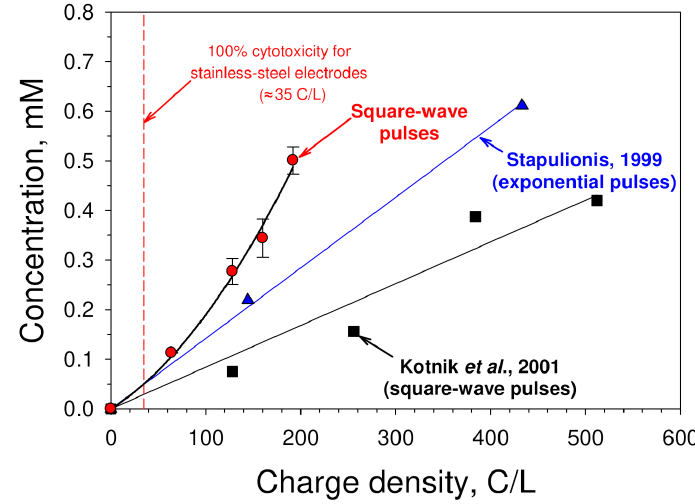
Figure 5. Release of iron ions from stainless steel electrodes. The total concentration of iron ions (Fe 3+ and Fe 2+ ) released from the stainless steel anode as a function of the charge that has flown through the sample per unit volume of the medium. Single square-wave electric pulses with a duration of 2 ms were used (red circles). The highest amplitude of the pulses was 240 V, which corresponded to the electric field strength of 1.2 kV/cm. The solution was 154 mM NaCl. For comparison, some of the results reported by other researchers [15,17] are shown here as